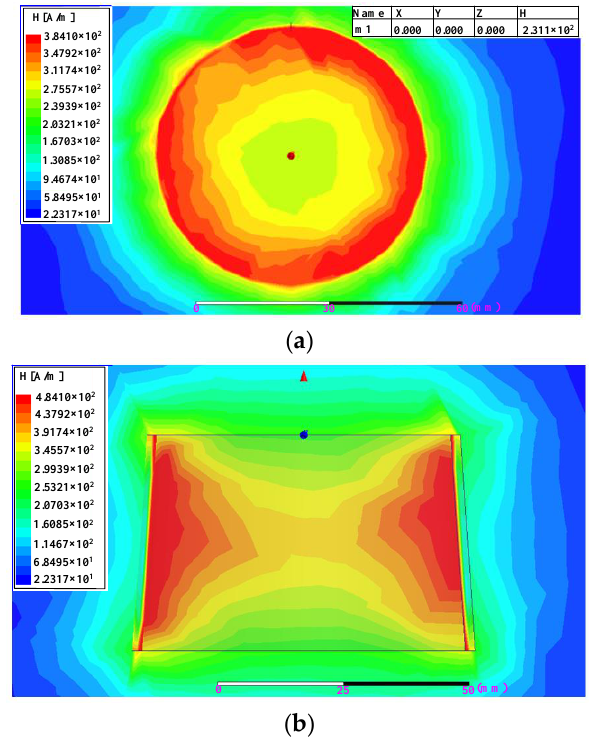
Figure 3. Simulated electromagnetic field of a four-layer tightly wound coil: ( a ) X – Y section of the electromagnetic field; and ( b ) X – Z section of the magnetic field.